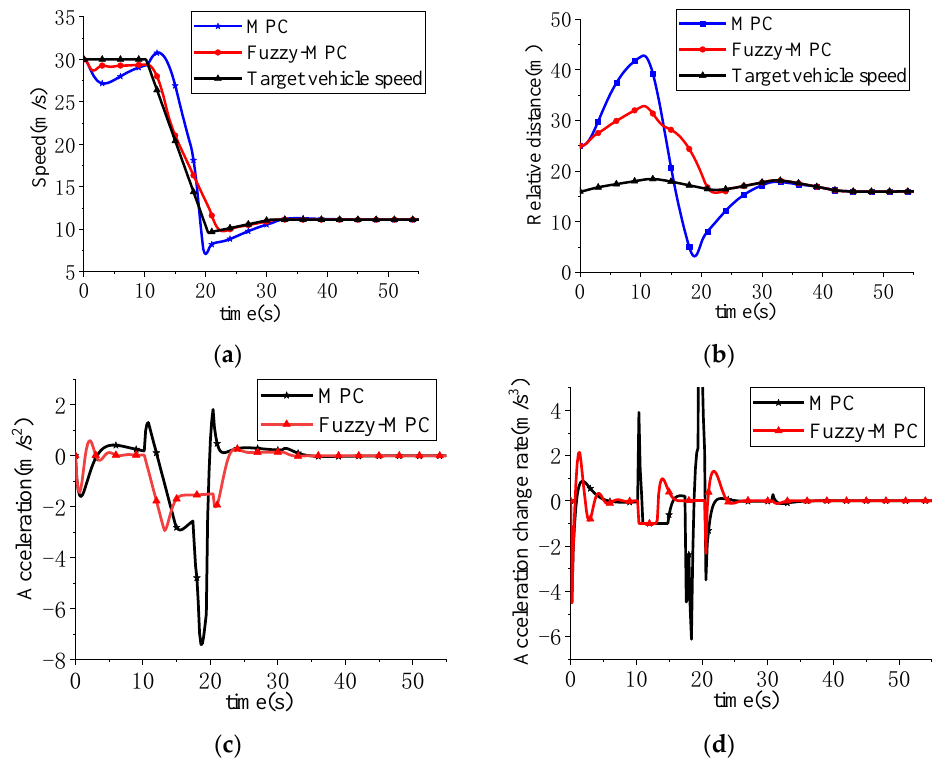
Figure 4. Emergency brake: ( a ) speed; ( b ) relative distance; ( c ) acceleration; ( d ) acceleration change rate.